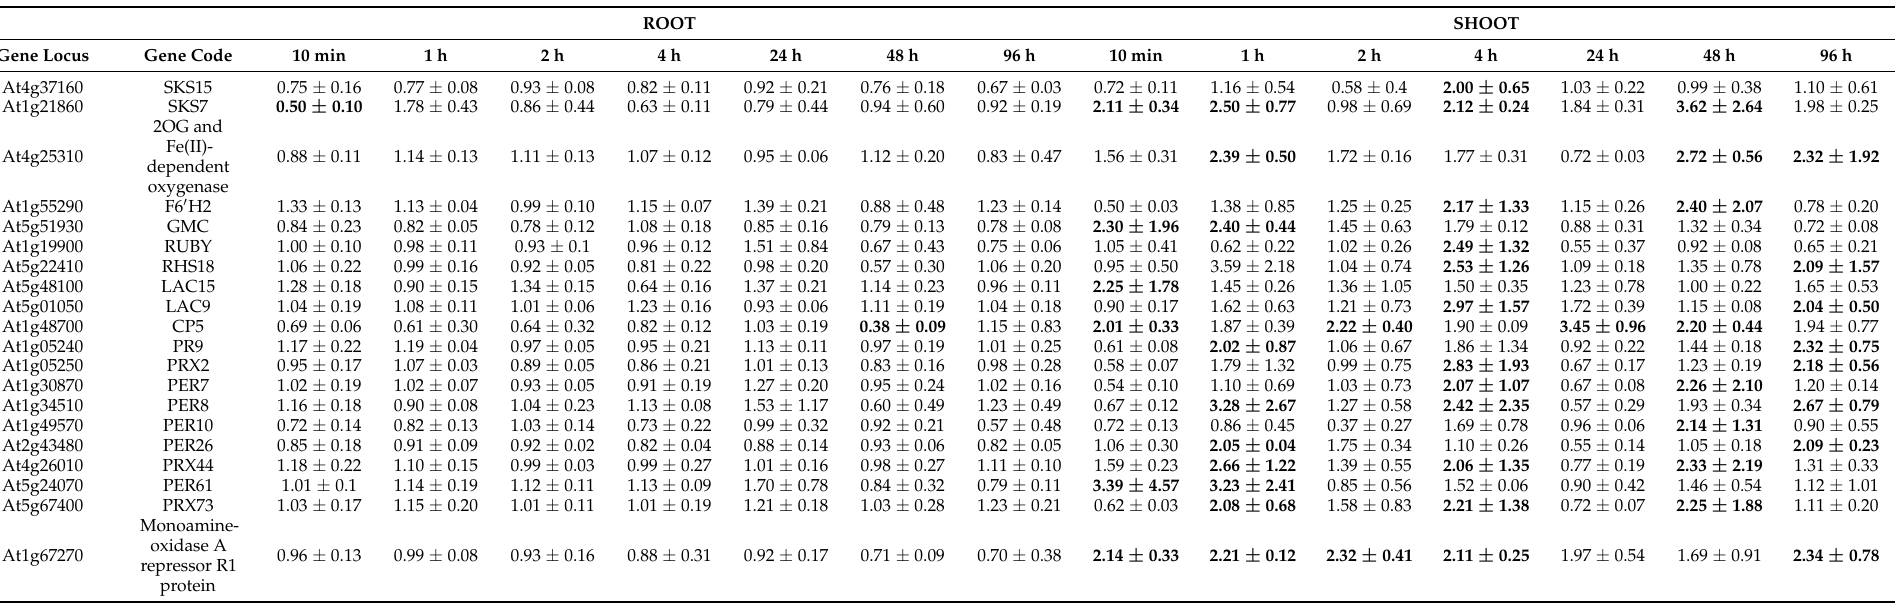
Table 1. Group A. Genes not regulated or downregulated in roots and upregulated in shoots. Genes were selected based on a fold change ≥ 2 or ≤ 0.5 in at least one time point. Values are expressed as the mean and standard deviation ( ± ), values with a fold change ≥ 2 or ≤ 0.5 are indicated as boldfaced numbers. ROOT SHOOT